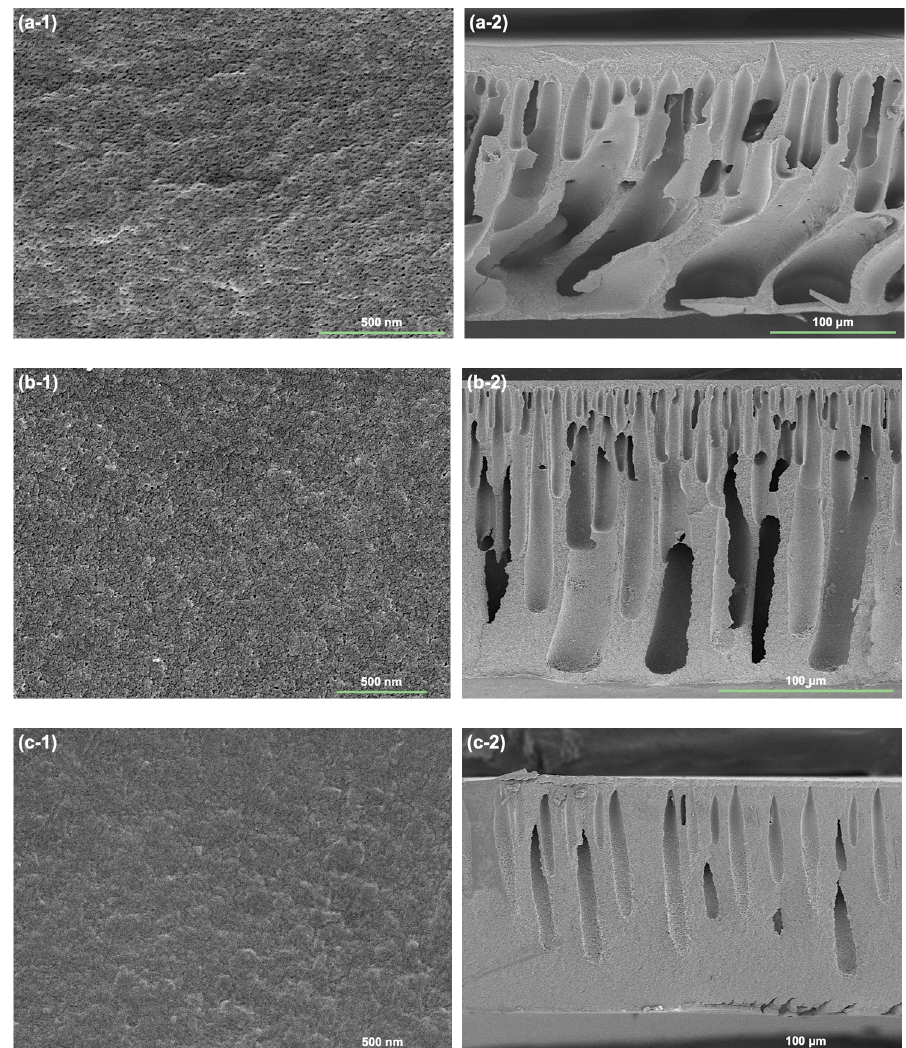
Figure 8. SEM images of the prepared membrane surface ( a-1 – c-1 ) and cross-section ( a-2 – c-2 ): ( a ) blank PAN, ( b ) M-0, and ( c ) M-3.